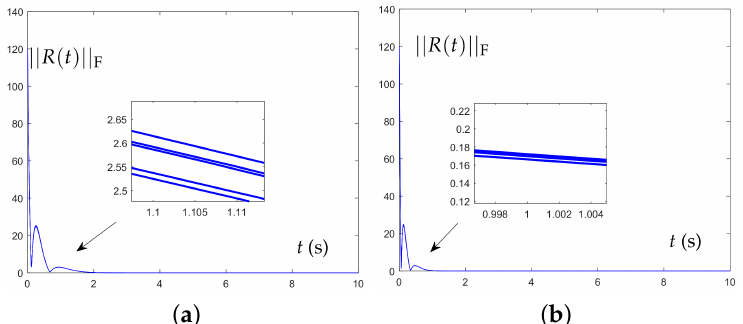
Figure 5. The error function norm (cid:107) R ( t ) (cid:107) F of the DIEZNN model with five randomly generated initial states (Equation (14)) is represented by blue solid curves for solving Equation (1) under linear noise 10 + 10 t . ( a ) Design parameters γ = 5. ( b ) Design parameters γ =